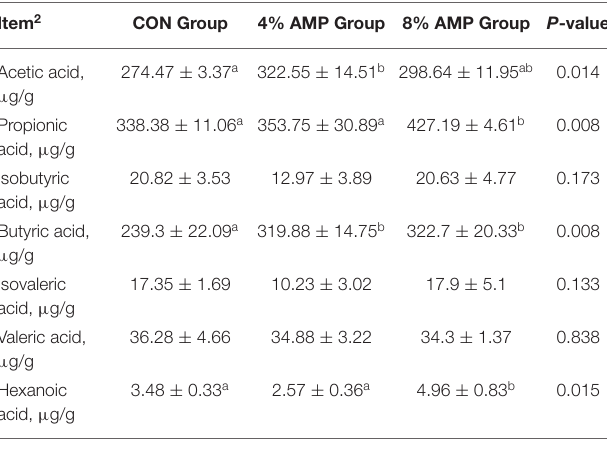
TABLE 6 | Effect of dietary AMP supplementation on volatile fatty acid contents in the cecum of pigs 1